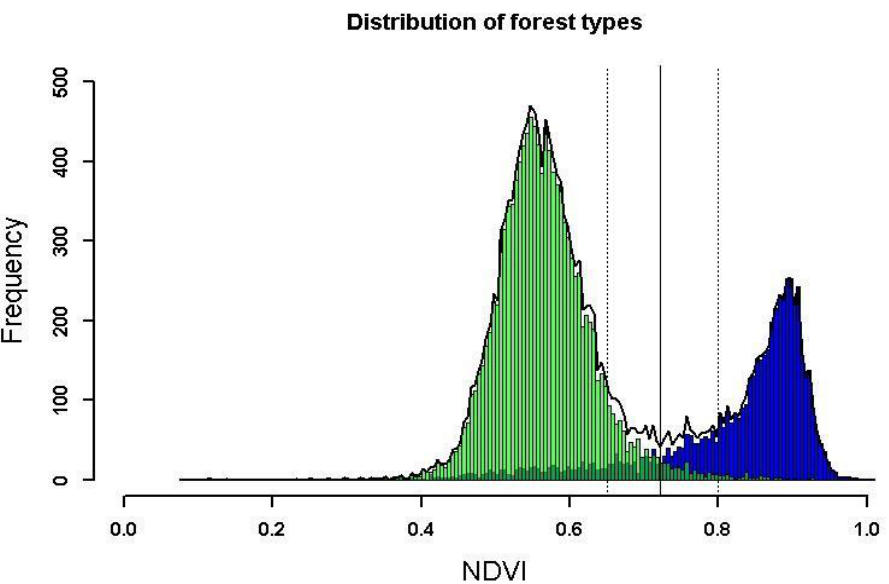
Figure 3. Distribution of broadleaved (green) and coniferous (blue) tree species in the reference data extracted from the Landsat 8 image. The black line depicts the sum of both classes. The vertical black line indicates the minimum turning point, the vertical dotted lines the distance of one-half standard deviation in the dataset, which is used as range for threshold parameterization.